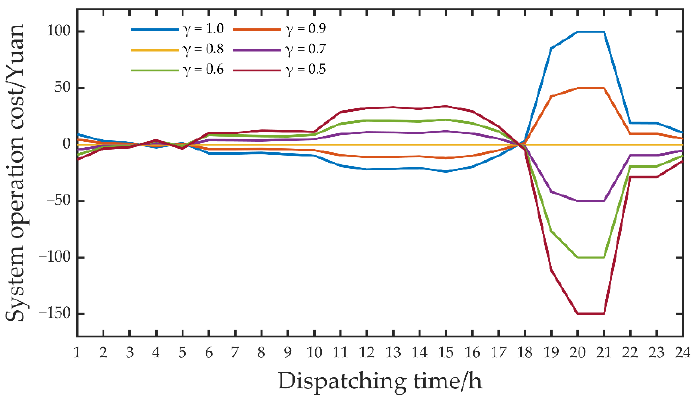
Figure 17. System operation cost under different mass flow rates.